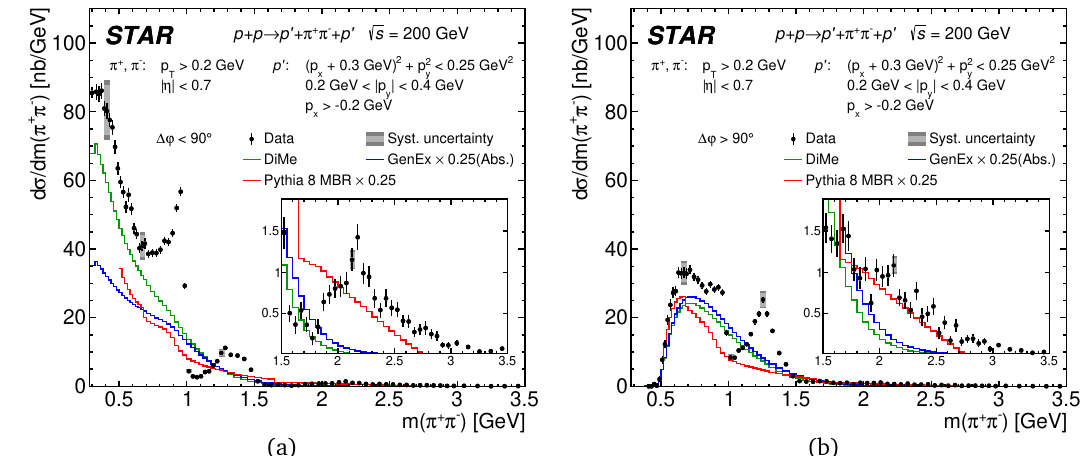
Figure 2: Differential cross sections for CEP of π + π − pairs as a function of the invari- ant mass of the pair in two ∆ ϕ regions: (a) ∆ ϕ < 90 ◦ and (b) ∆ ϕ > 90 ◦ , measured in the fiducial region explained on the plots [ 5 ] . Data are shown as solid points with error bars representing the statistical uncertainties. The typical systematic uncer- tainties are shown as grey boxes for only a few data points as they are almost fully correlated between neighbouring bins. Predictions from Monte Carlo models GenEx, DiMe and MBR are shown as histograms.